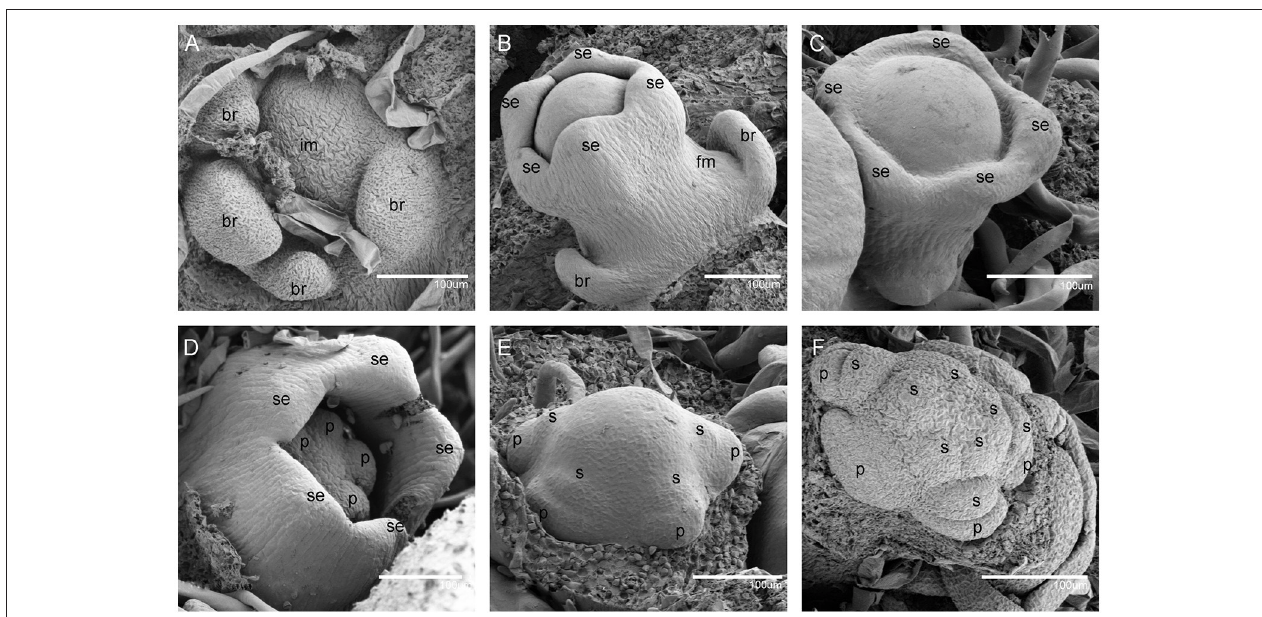
FIGURE 2 | Scanning electron micrographs for V. fordii flower in stages 1–6. (A) Stage 1: inflorescence meristem was subtended by bracts. (B) Stage 2: floral meristem initiated on the flank of inflorescence. (C) Stage 3: appearance of sepal primordia. (D) Stage 4: formation of petal primordia. (E) Stage 5: appearance of lower layer stamens. (F) Stage 6: upper layer stamens bulged. im, inflorescence meristem; br, bract; fm, floral meristem; se, sepal; p, petal; s,